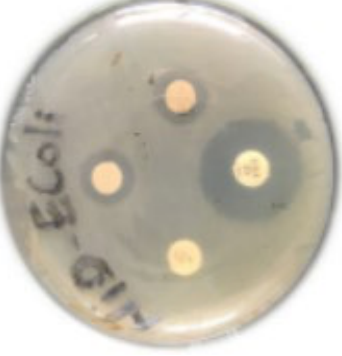
Fig. 10. Lawn culture of E. coli indicating zone of inhibition around NiO nanoparticle coated discs and standard antibiotic discs after 18 hrs of incubation at 37 ° C